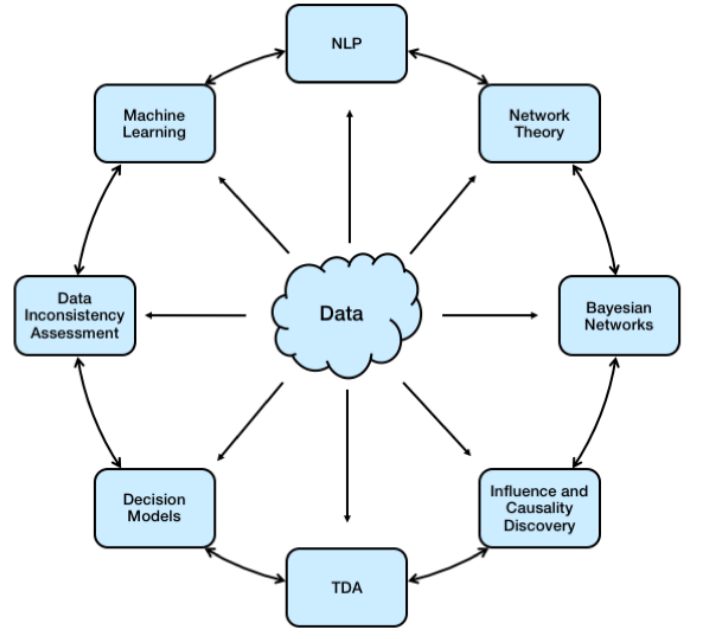
Figure 1. The main research areas discussed in this article, and their mutual